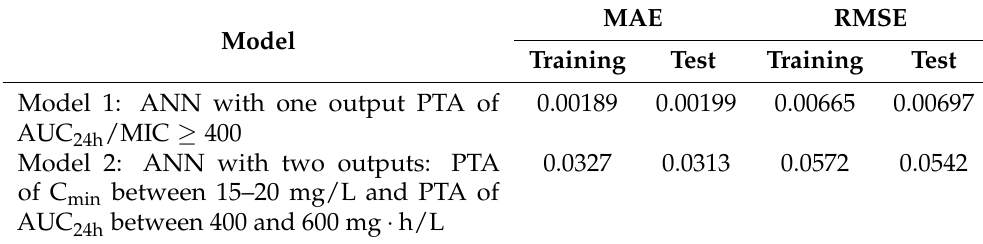
Table 3. Predictive performance in trained neural networks for training and validation data generated from the